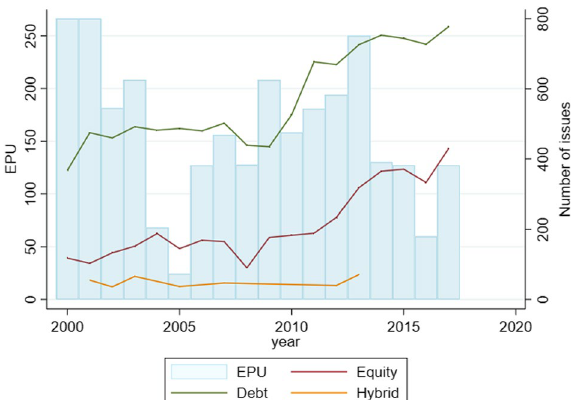
Fig. 3 The number of instruments used by the sample firms from 2000 to 2017 (2018 is omitted because of incomplete data for that year). The y-axis on the left shows the scale for the EPU index, while the y-axis on the right shows the number of issues made by a certain